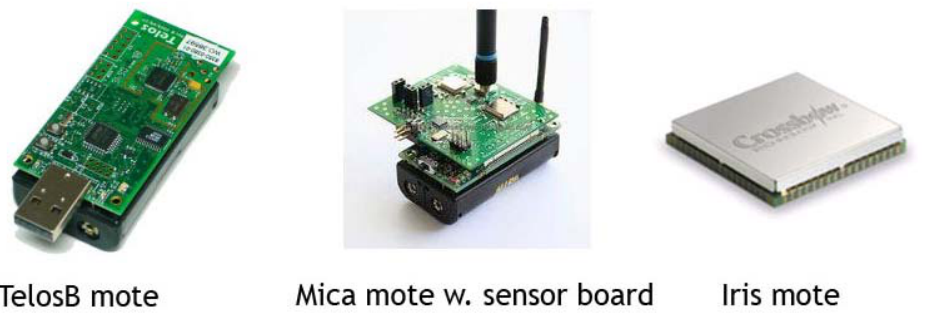
Figure 1. Computing platform